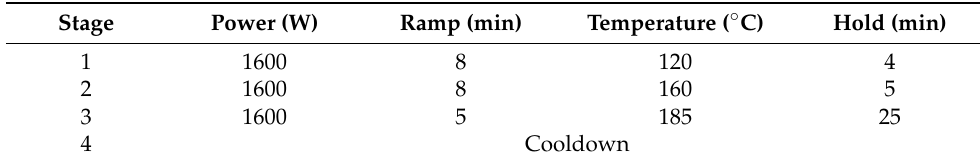
Table 3. The running program of microwave digester.